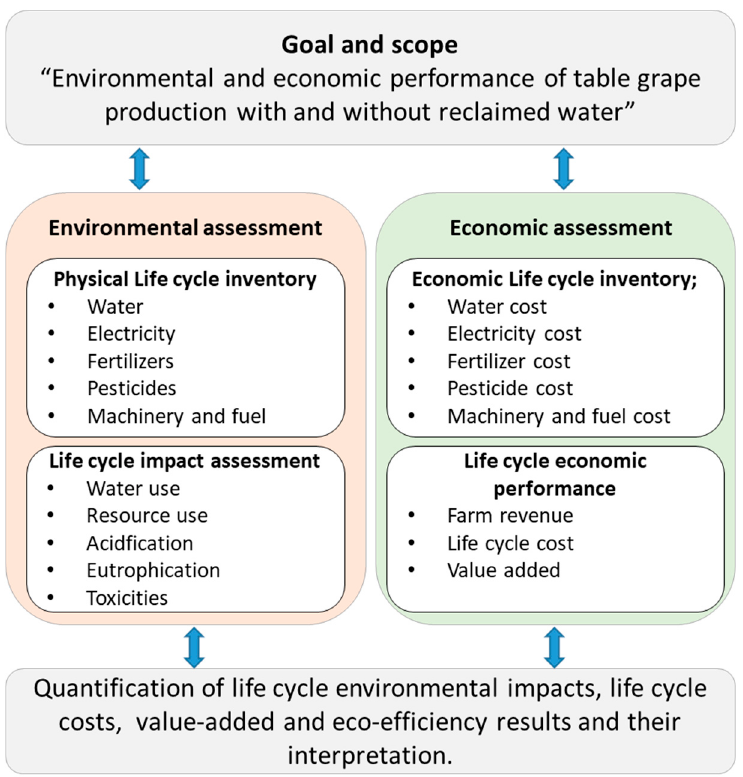
Figure 2. Framework for environmental and economic analysis adopted in this study (modified from ISO 14045:2012).